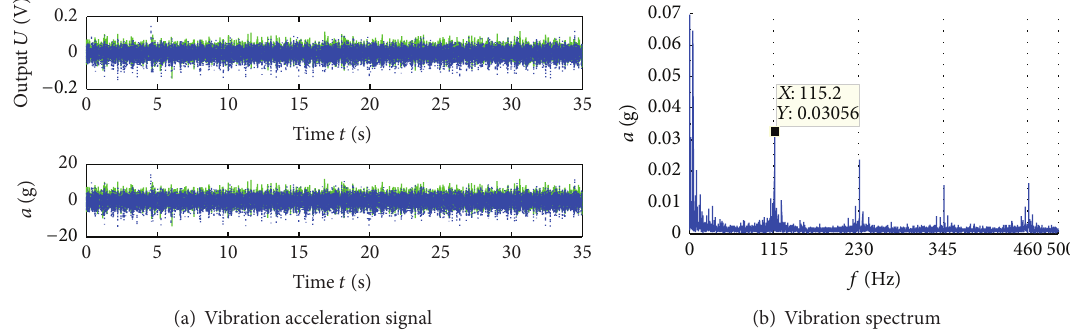
Figure 5: Vibration signal detection of gearbox with no modification gear.